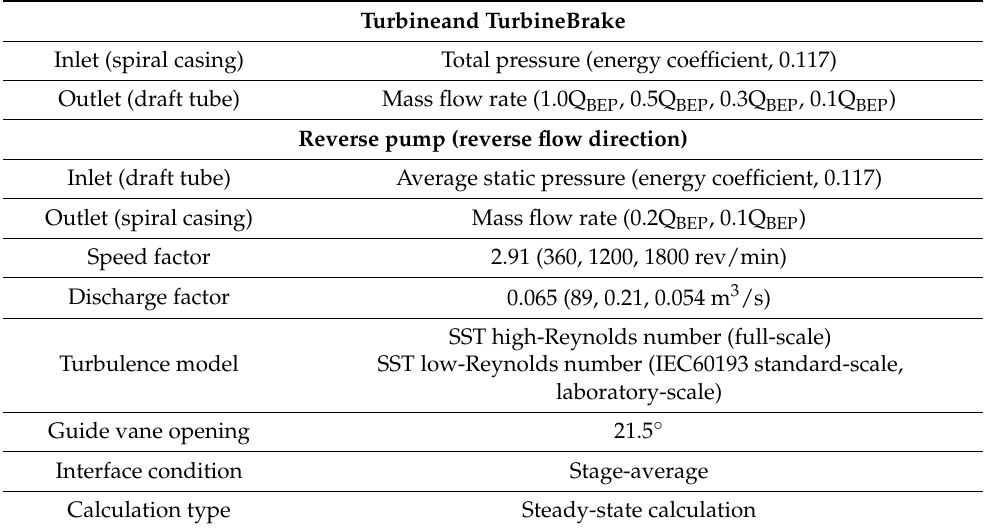
Table 2. Boundary conditions for predicting S-shaped characteristics among model scales.